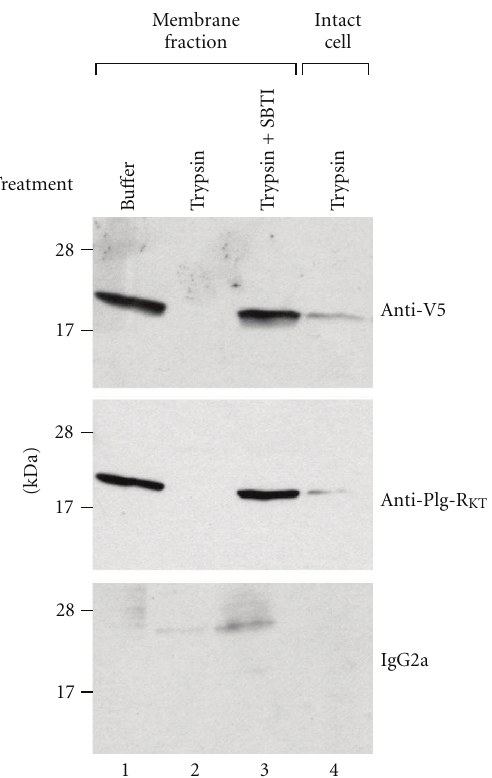
Figure 4: The N-termini and C-termini of Plg-R KT are exposed on the cell surface. Membrane fractions of PC12 cells stably transfected with V5-pCIneo-Plg-R KT were incubated with either bu ff er (lane 1), trypsin (1mg/mL) (lane 2), or trypsin 1mg/mL + soybean trypsin inhibitor (SBTI) (2mg/mL) (lane 3) for 30 minutes at 37 ◦ C or intact PC12 cells were incubated with 1 mg/mL trypsin for 2hr at 37 ◦ C, followed by 2mg/mL SBTI for 15 min. Following neutralization of trypsin with SBTI, the membrane fraction was prepared from the treated, intact cells (lane 4). 30 μ g/lane of membrane fractions was electrophoresed on 18% SDS page under reducing conditions and western blotted with either anti-V5, anti-Plg-R KT mAb, or isotype control. This research was originally published in